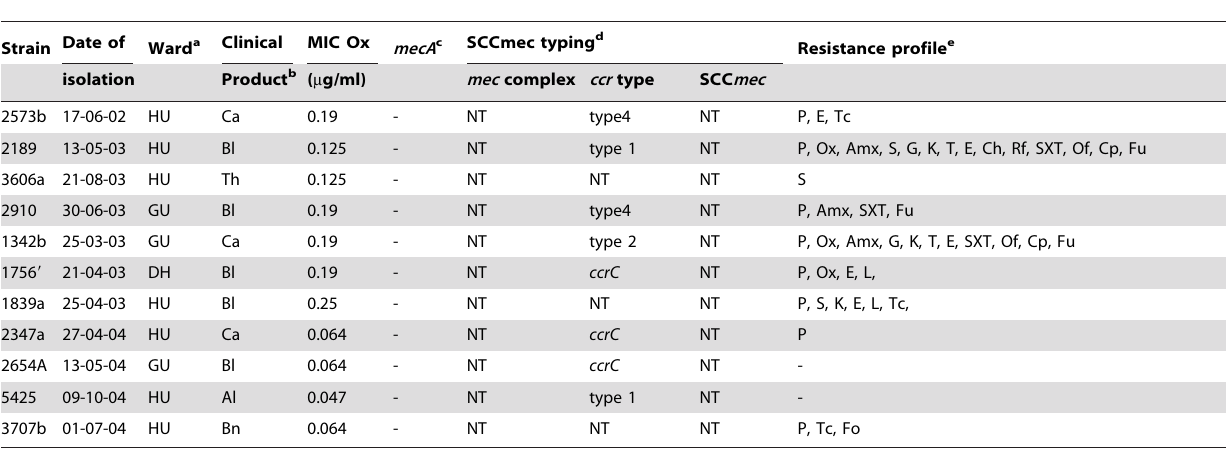
Table 2. Molecular and phenotypic characterization of the 11 methicillin-susceptible S. hominis (MSSHo) isolates.